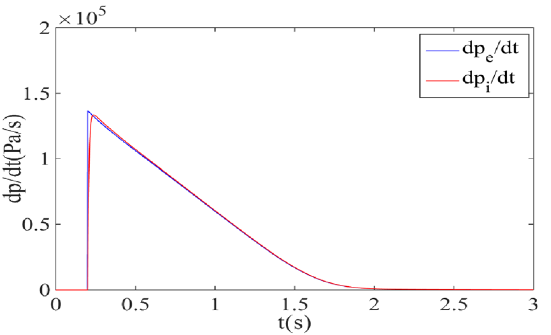
Figure 3. Calculation curve and measurement curve of pressure change rate of the air metal container by simulation.